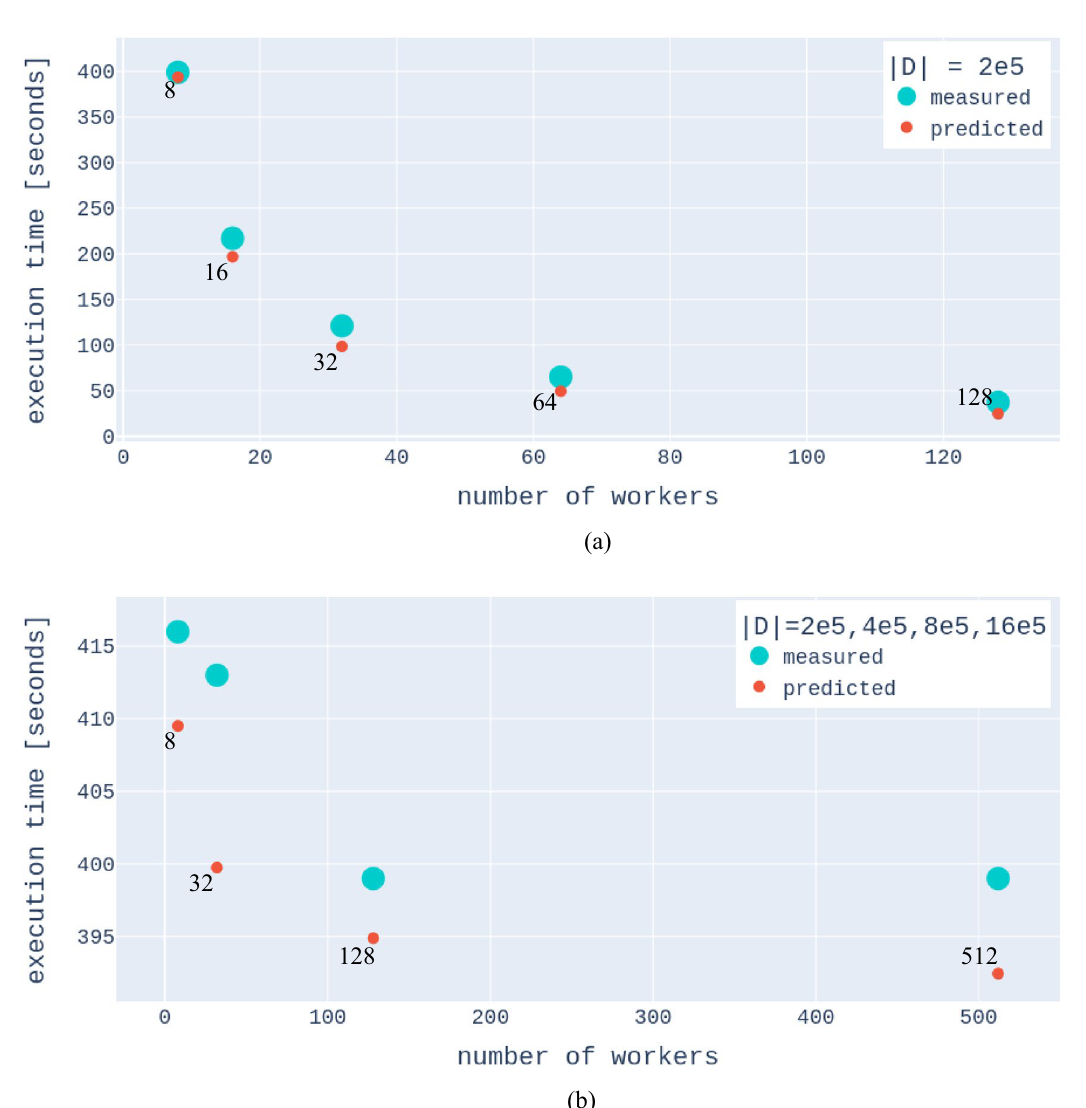
Figure 5. Figure illustrating theoretical and measured strong and weak scaling of the distributed covariance computation. ( a ) The computation time of a problem of fixed size as a function of the number of workers. ( b ) Computation time as a function of the number of workers while the problem dataset size is increased (from the left 2e5, 4e5, 8e5, 16e5, also see label). The figures suggest that there is a strong case to be made for the favorable scalability of exact Gaussian processes. The exact number of workers in each run is indicated as numbers adjacent to the